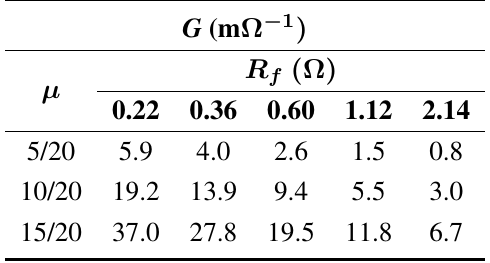
Table 2. G values of the realized faults in the faulty motor.